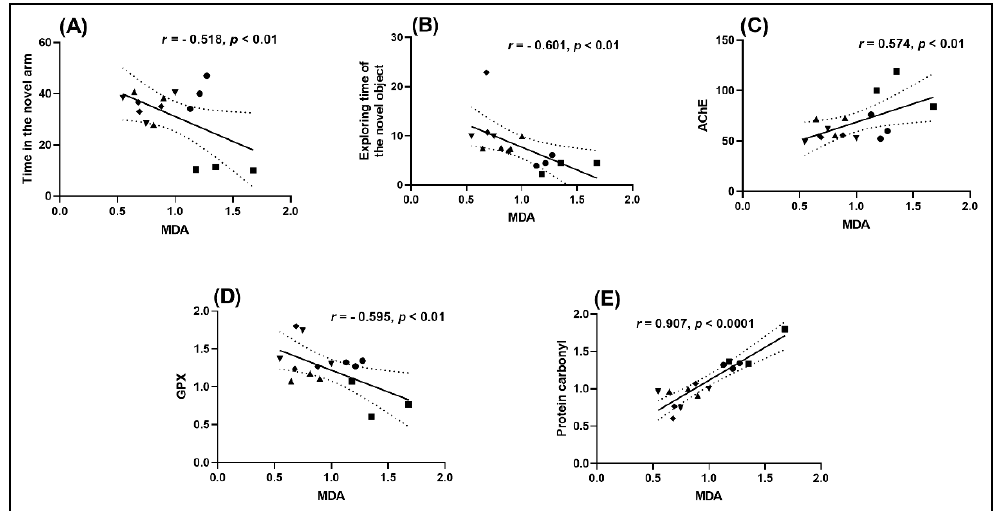
Figure 5. Correlation analyses between behavioral and biochemical parameters (Pearson’s correlation). Data expressed are time in the novel arm (s), exploring the time of the novel object (s), AChE (nmol/min/mg protein), GPX (U/mg protein), protein carbonyl (nmol/mg protein), and MDA (nmol/mg protein). ( A ) Time in the novel arm vs. MDA ( n = 10, r = − 0.518, p < 0.01); ( B ) Exploring time of the novel object vs. MDA ( n = 10, r = − 0.601, p < 0.01); ( C ) AChE vs. MDA ( n = 10, r = 0.574, p < 0.01); ( D ) GPX vs. MDA ( n = 10, r = − 0.595, p < 0.01) and ( E ) protein carbonyl vs. MDA ( n = 10, r = 0.907, p < 0.0001) in control (●), scopolamine (Sco) ( ■ ), and baicalein 5,6-dimethyl ether (( ▲ ) 1, ( ▼ ) 3, and ( ♦ ) 5 μg/L) groups.